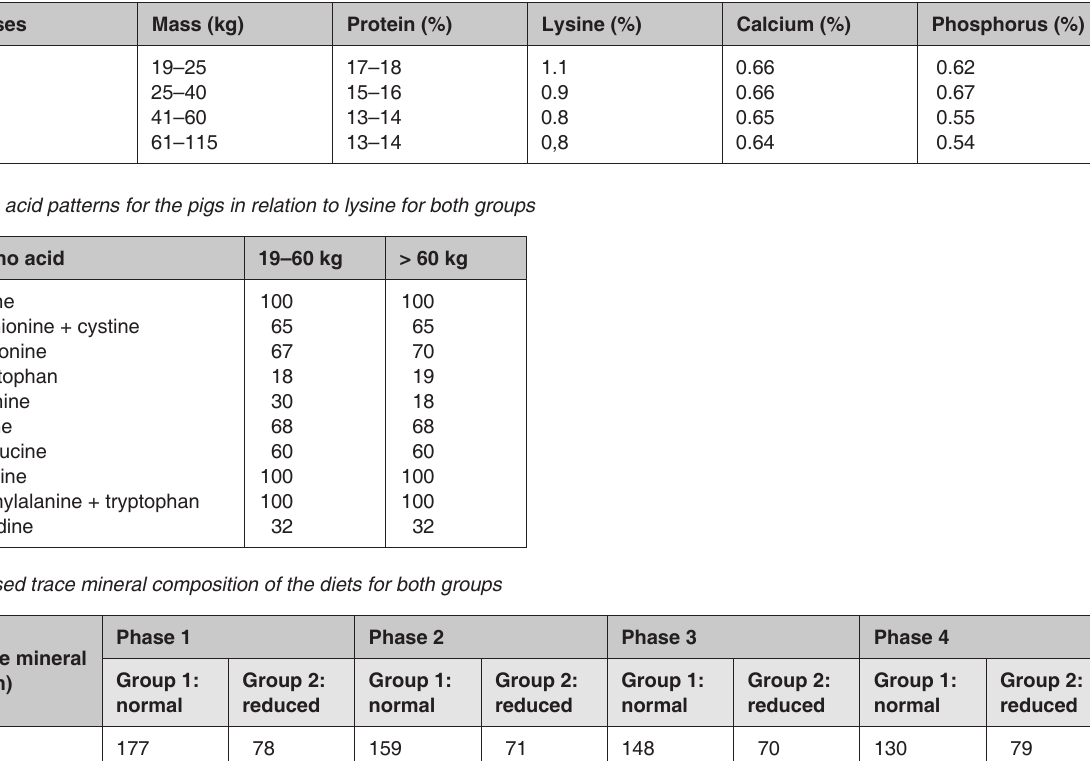
TABLE 2 Experimental diets of the pigs. Group 1 received the trace mineral levels suggested by the NRC, USA (1998), while Group 2 received reduced levels Diet formula for both groups of pigs weighing from 19–115